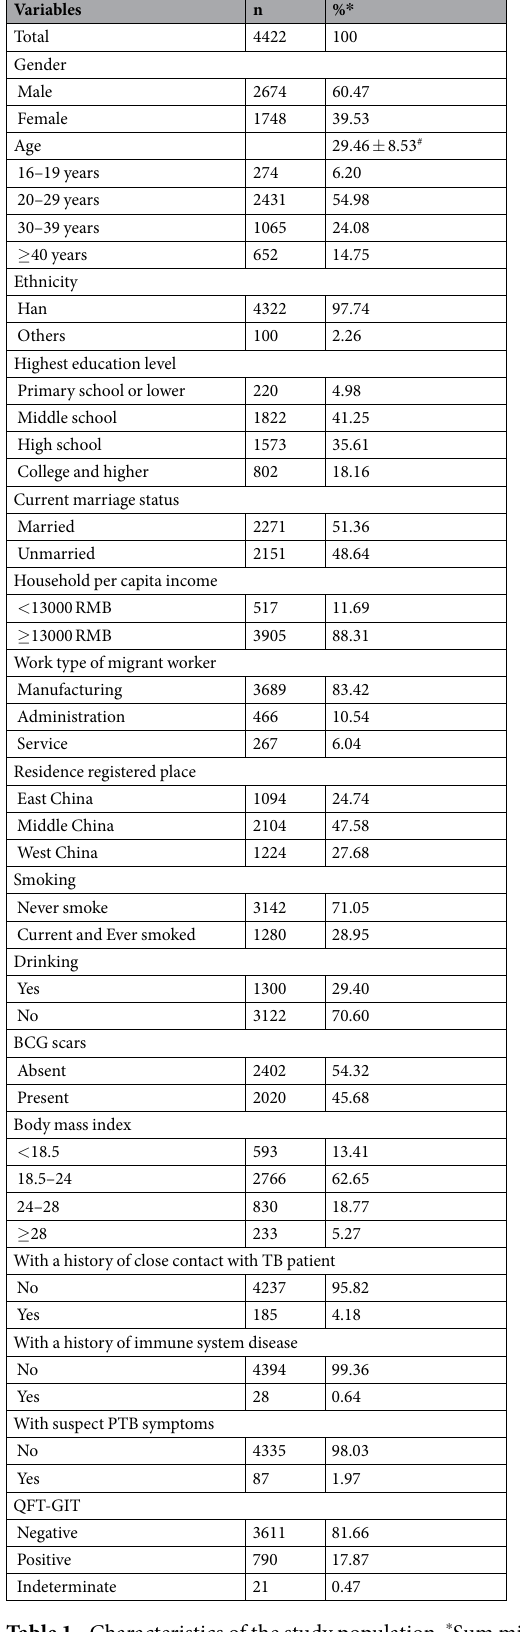
Table 1. Characteristics of the study population. * Sum might not always be in total because of missing data. # Means ± standard deviation. Abbreviation: BCG = Bacillus Calmette-Guerin. BMI = body-mass index. PTB = Pulmonary tuberculosis. TB = Tuberculosis. QFT = QuantiFERON-TB Gold